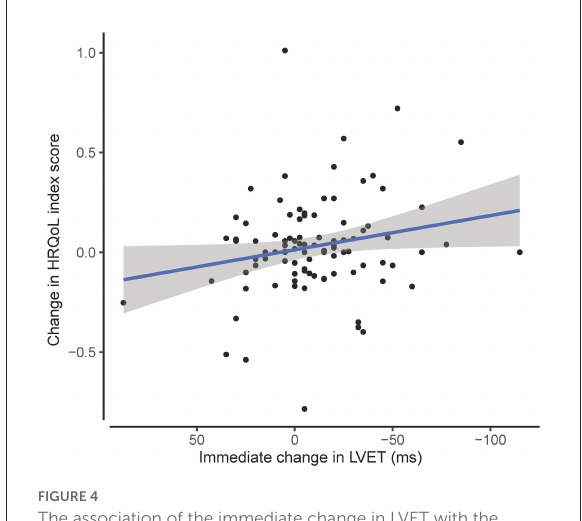
FIGURE4 The association of the immediate change in LVET with the change in HRQoL index score following TAVI. Post TAVI HRQoL index score increases with 0.02 index points per 10ms immediate decrease in LVET ( p = 0.042). HRQoL, health related quality of life; LVET, left ventricular ejection